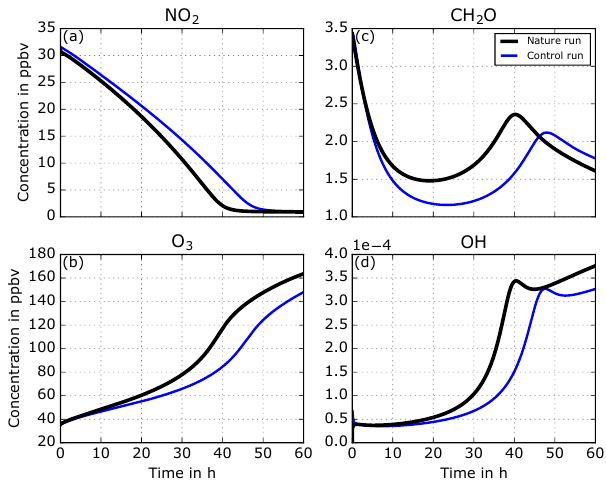
Figure 4. Time series of concentrations of NO 2 , O 3 , CH 2 O, and OH over 60h from the control run (MOZART-T1, blue lines) and from the nature run (MCMv3.3.1, black